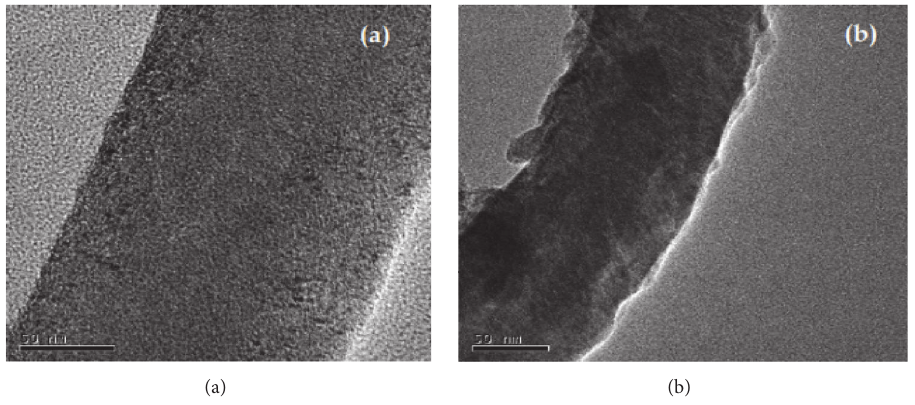
Figure 4: Transmission Electron Microscopy images